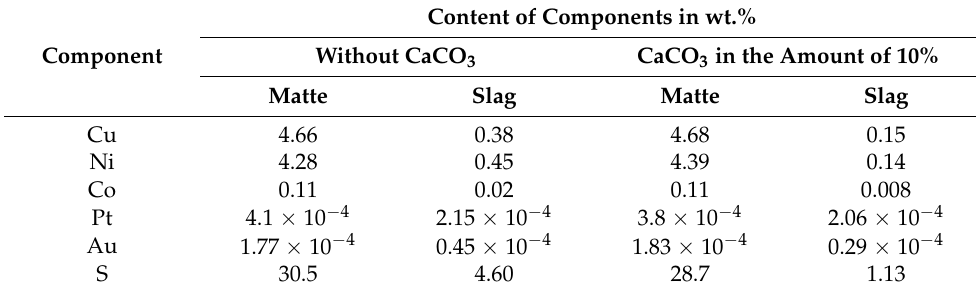
Table 4. Content of sulfur, non-ferrous, and noble metals in matte and slag after melting the charge without and with the addition of CaCO 3 .